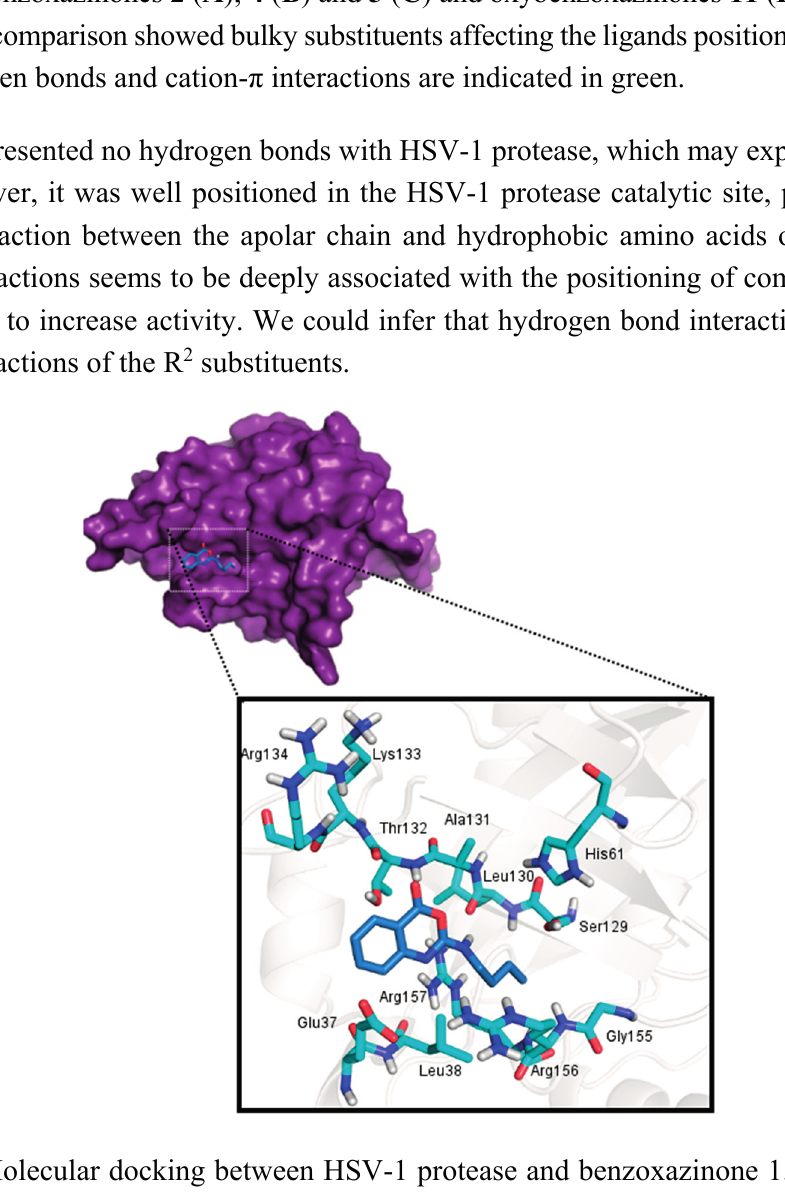
Figure 6. Molecular docking between HSV-1 protease and benzoxazinone 1. The absence of hydrogen interactions and the presence of hydrophobic interactions could be responsible for positioning the ligand at the binding